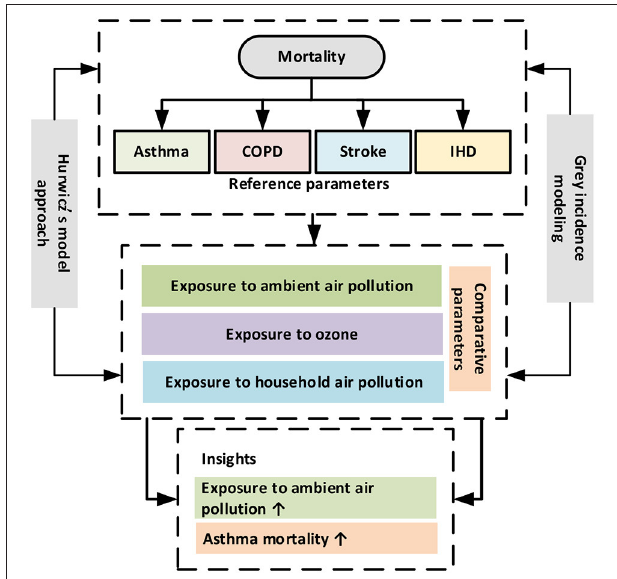
FIGURE 1 | The visual